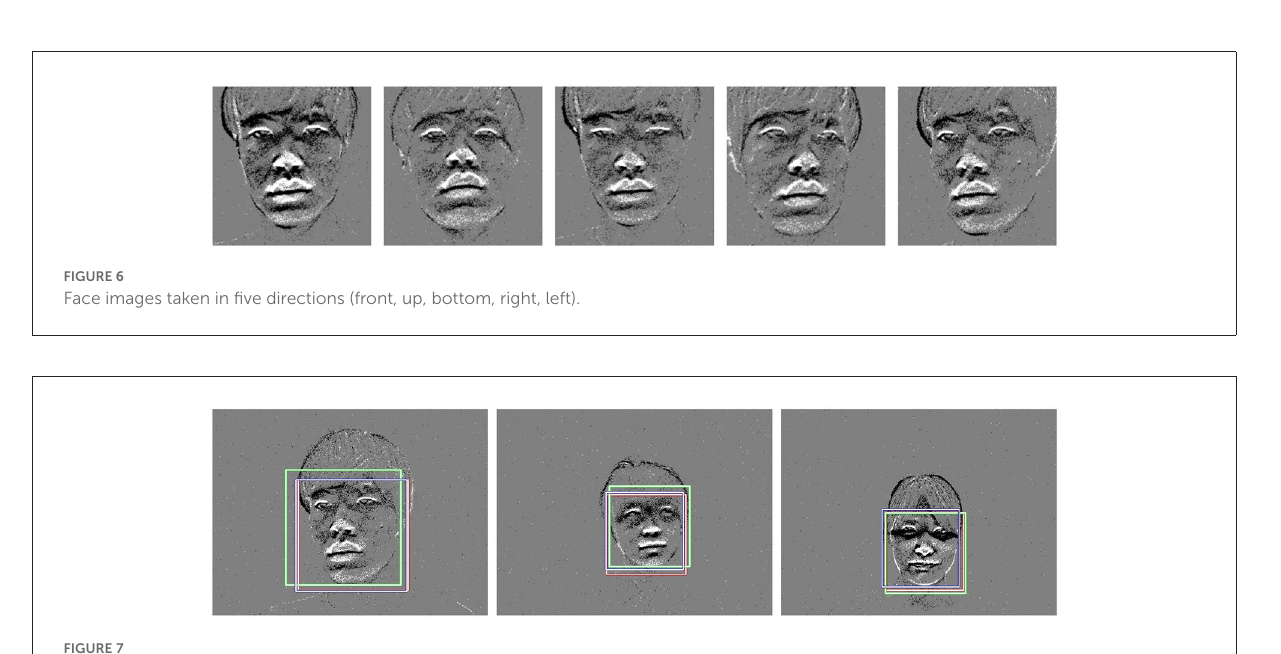
collected per subject. We collected 405 facial images from all 23